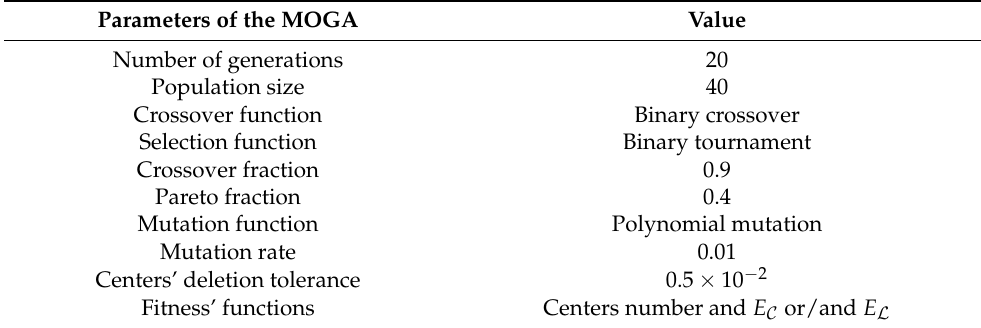
Table 1. Parameters and functions used by MOGA in the simulations results. Parameters of the